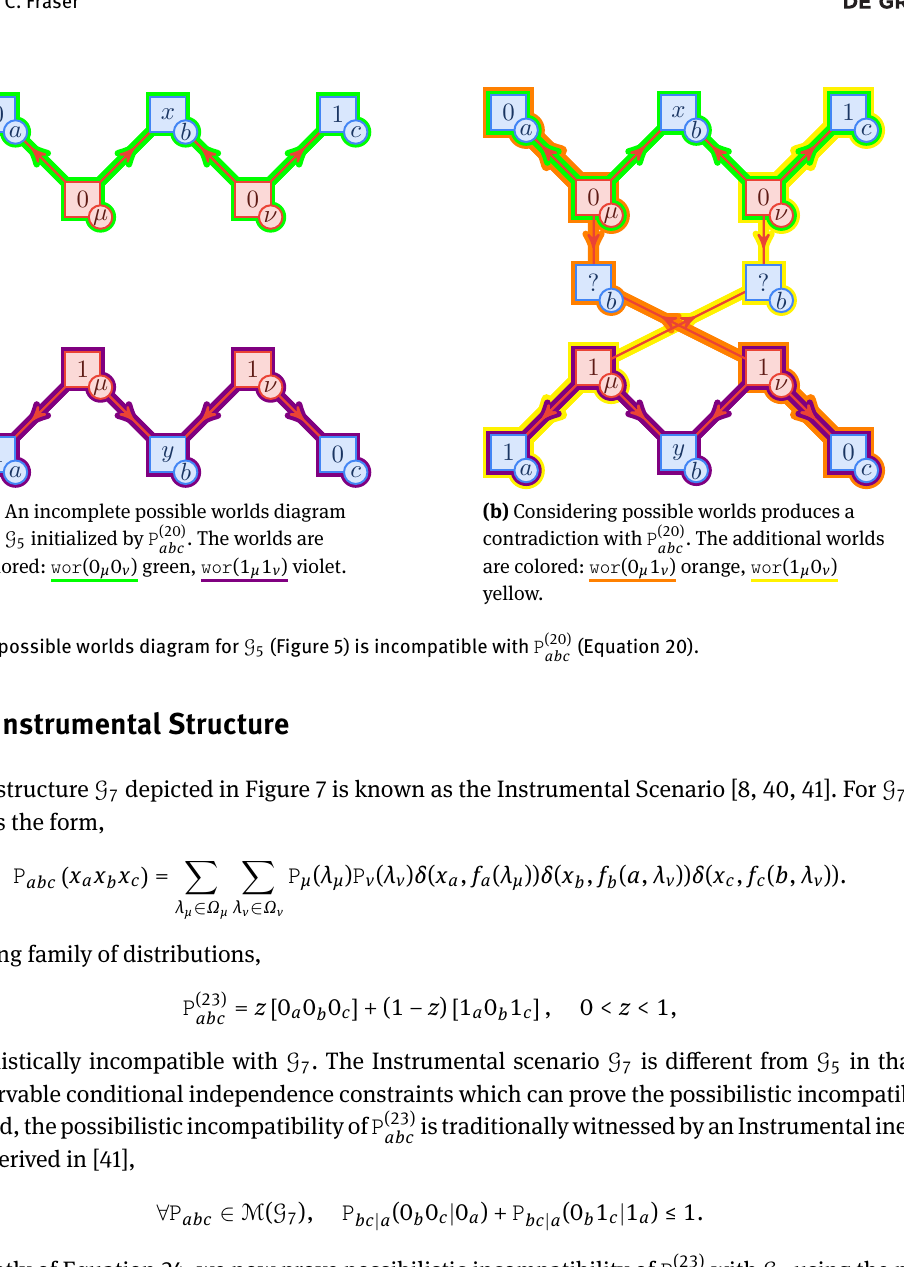
Figure 6: The possible worlds diagram for G 5 (Figure 5) is incompatible with P (20)